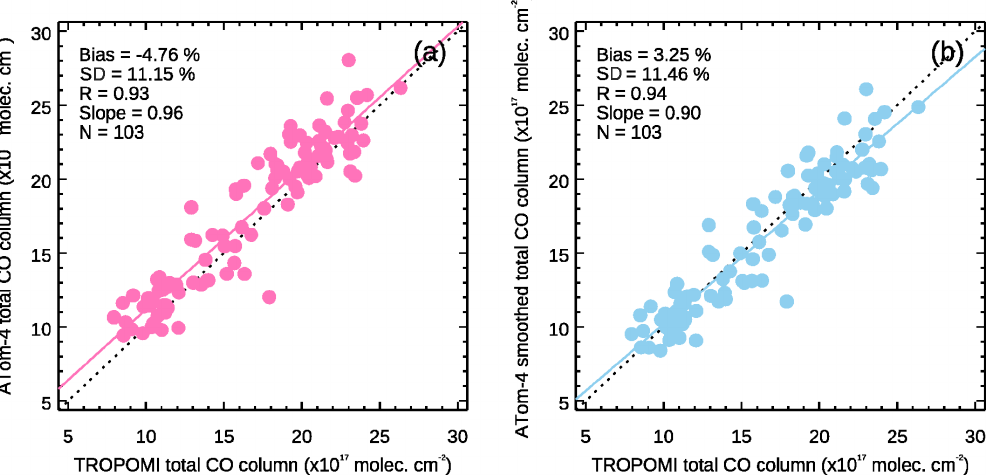
Figure 6. Comparison of colocated retrievals over bodies of water from TROPOMI and ATom-4 (24 April–21 May 2018). (a) TROPOMI vs. true (unsmoothed) ATom-4. (b) TROPOMI vs. retrieval-simulated (smoothed) ATom-4. Table 2. Colocated TROPOMI vs. ATom-4 CO retrievals over bodies of water: statistics from AK analysis. Relative bias and SD are in percent. Column bias and SD are in units of 10 17 moleccm − 2 . TROPOMI vs. TROPOMI vs. retrieval- true